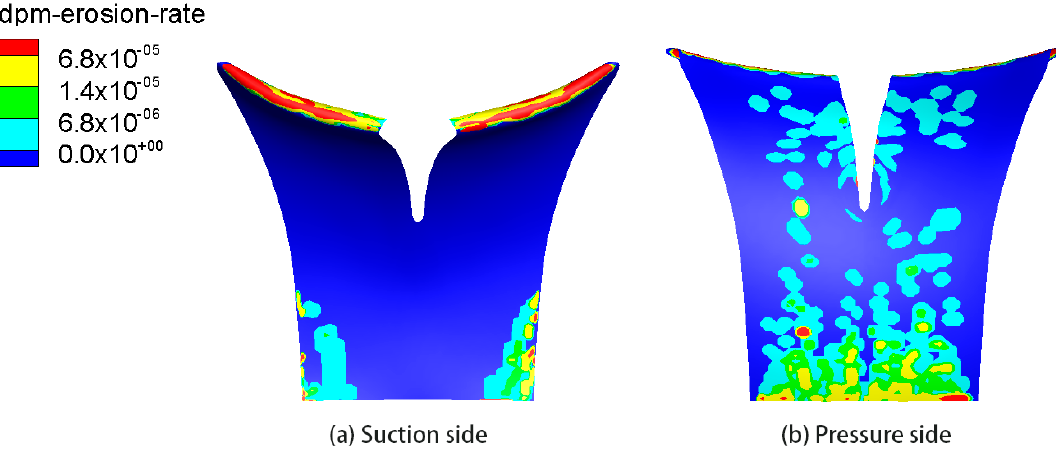
Figure 14. Silt erosion on blade surface (units: μ m/s, silt concentration: 3.5 kg/m 3 ).